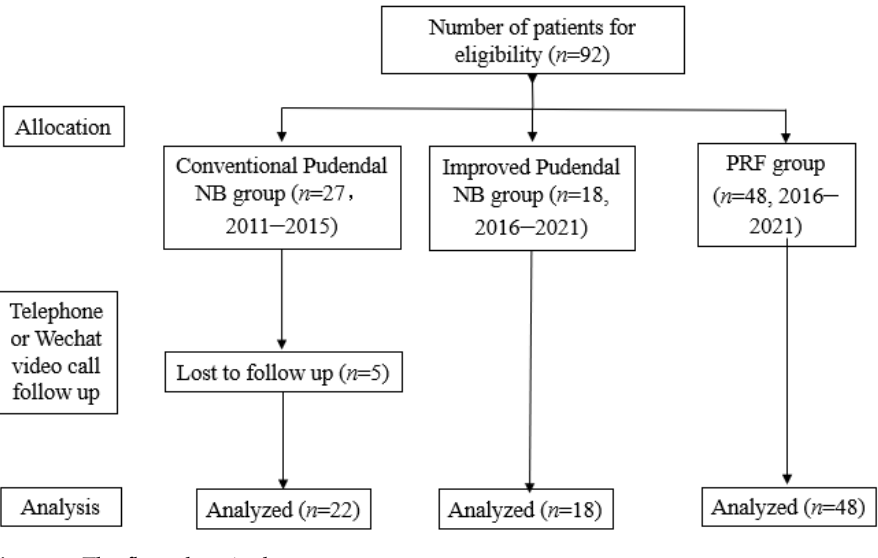
Figure 1. The flow chart is